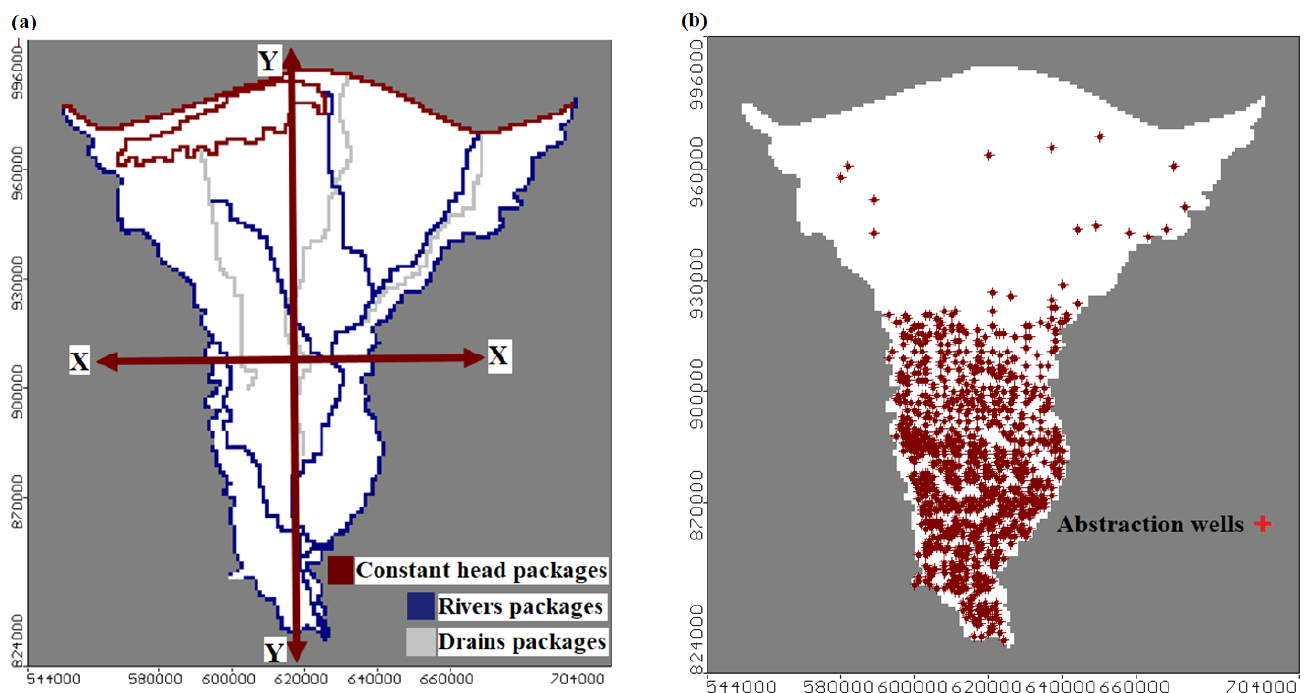
Figure 4. ( a ) Model boundary condition and ( b ) distribution of abstraction wells in MNDA.